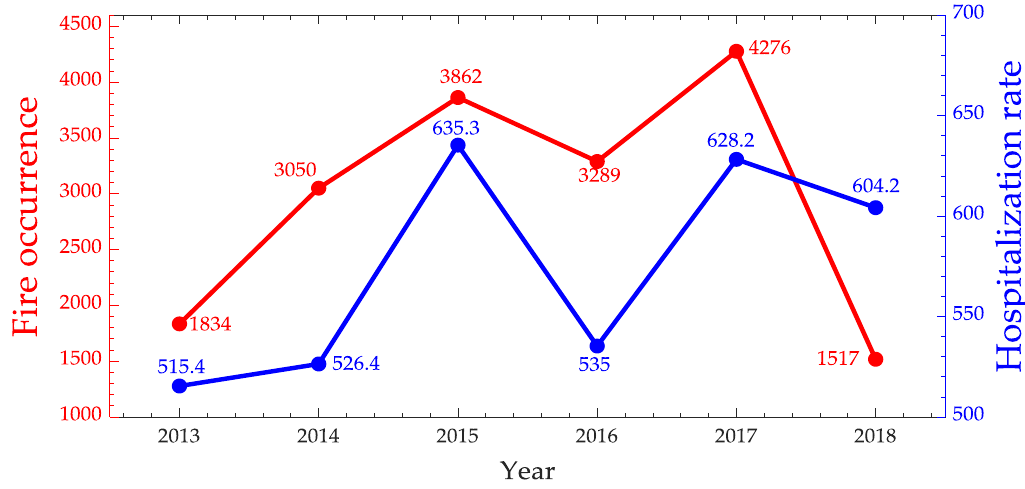
Figure 16. Time series of fire occurrences in red and hospitalization rate due to respiratory system diseases for children 0–4 years old in blue from July to December for Mato Grosso